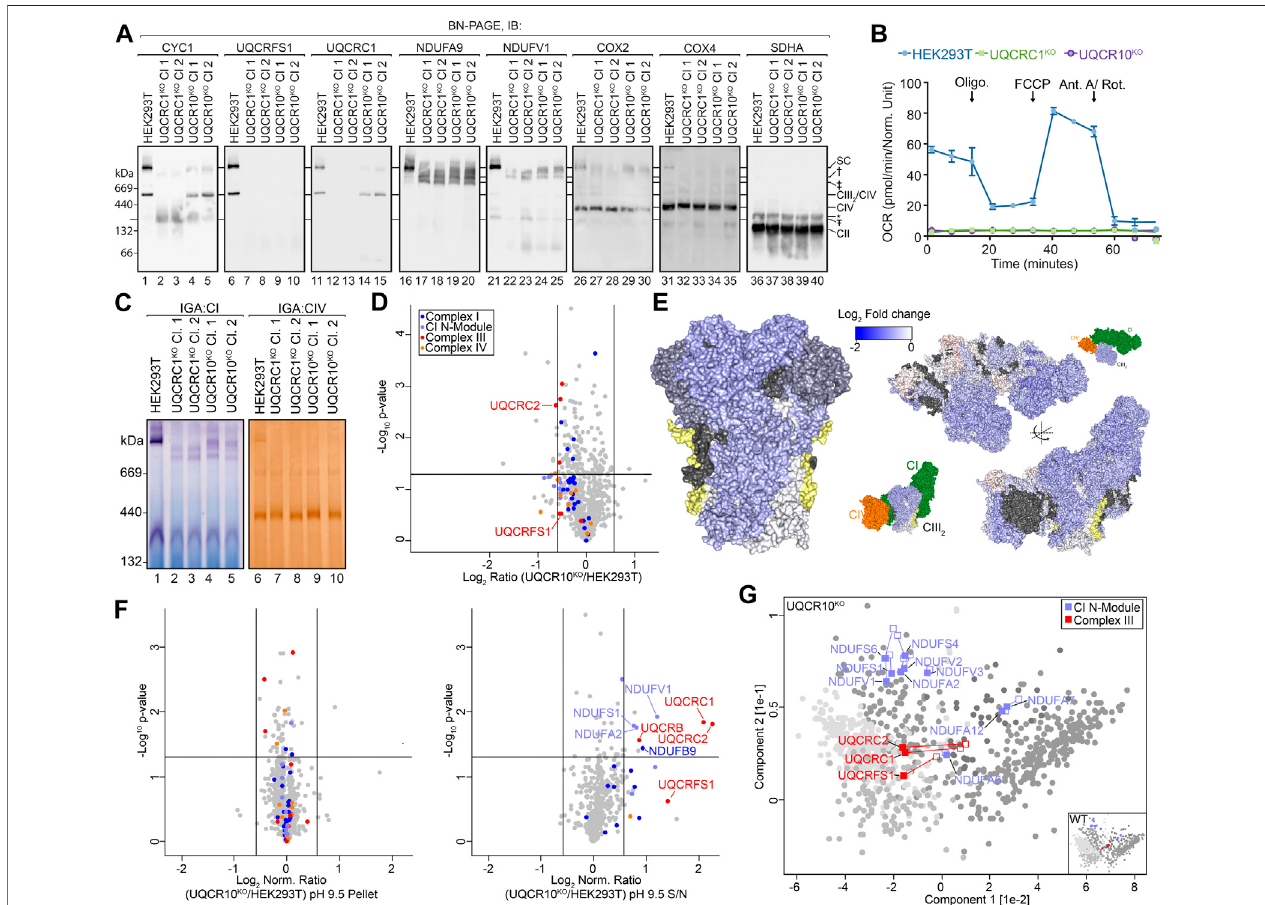
FIGURE3| LossofUQCR10leadstodestabilizationandaccumulationofasolublecore-module. (A) Mitochondriaisolatedfromindicatedcelllinesweresolubilized in 1% digitonin and analyzed by BN-PAGE and immunoblotting with the indicated antibodies. Ŧ , † and ‡ represent sub-assemblies discussed in text. *non-speci fi c complex. (B) Oxygen consumption rates of HEK293T, UQCRC1 KO and UQCR10 KO cell lines. Oligo, oligomycin; FCCP, carbonyl cyanide 4-(tri fl uoromethoxy) phenylhydrazone; AntA,antimycin A;Rot,rotenone. (C) Mitochondria isolatedfrom indicatedcelllines wereanalyzed usingBN-PAGEand theactivityofcomplexI and IV determined through in-gel assays. (D) Volcano plot depicting relative abundances of mitochondrial proteins in UQCR10 KO compared to HEK293T. (E) Topographical heatmap showing changes in abundance of CIII and respirasome subunits in UQCR10 KO using the CIII (PDB 5XTE) and respirasome (PDB 5XTH) structures. UQCR10 shown in yellow. (F) Volcano plots depicting relative abundance of proteins in pH 9.5 carbonate extraction pellet and supernatant fractions in UQCR10 KO compared to HEK293T mitochondria following normalization against the total fraction. Data prior to normalization and pH 11.5 data can be found in Supplementary Figures S1, S2 . (G) Principal component analysis showing overall membrane association pro fi les in UQCR10 KO relative to HEK293T mitochondria. Complex I N-module and CIII subunits are labeled, with their position in control data shown as empty squares and position in knockout data as fi lled squares. Clusters de fi ned in Figure 2A are colored in